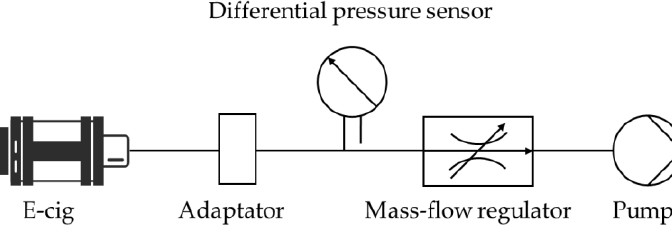
Figure 7. Experimental setup to carry pressure drop measurement.